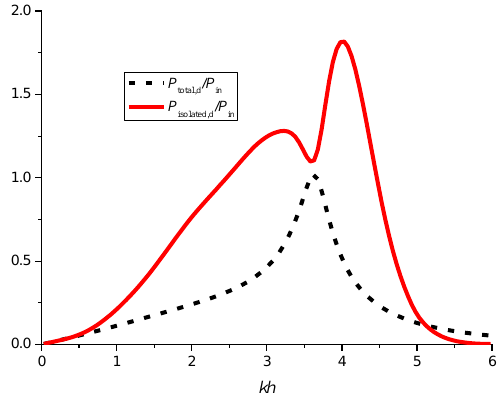
Figure 6. Variations of dimensionless total extracted power of the WEC array ( P total,d ) and the dimensionless extracted power of the isolated WEC ( P isolated,d ) with the dimensionless wave number kh.